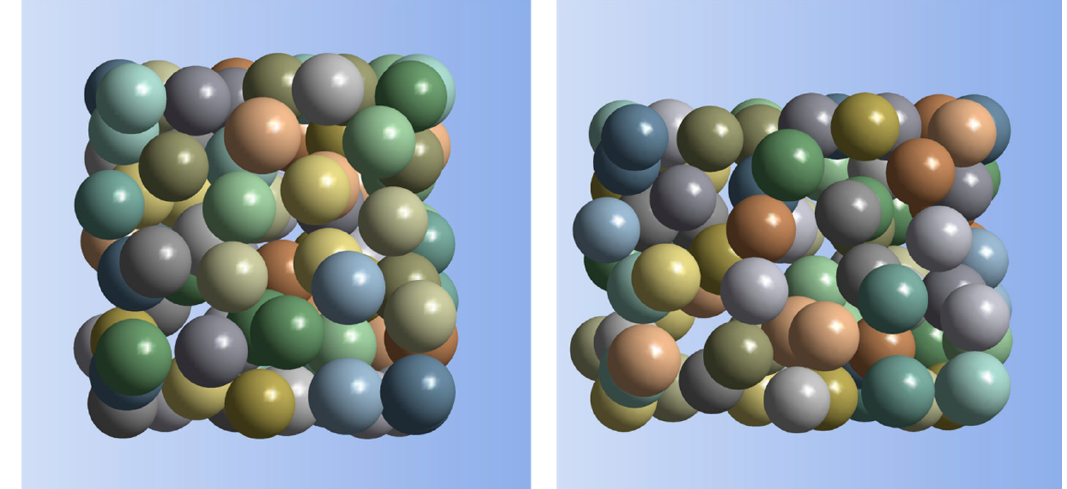
Figure 16. An illustration of the applied tensile strain and Poisson’s effects on filler particle proximity: particles in undeformed RVE ( left ), and particles in deformed RVE ( right ), for 90,000 microstrain applied to the RVE (horizontal), RVE and particle size of 30 nm and 5 nm, respectively, and filler loading of 30 vol%. For clarity, the matrix material is not shown, and deformations and displacements are depicted with a 150× scaling factor.